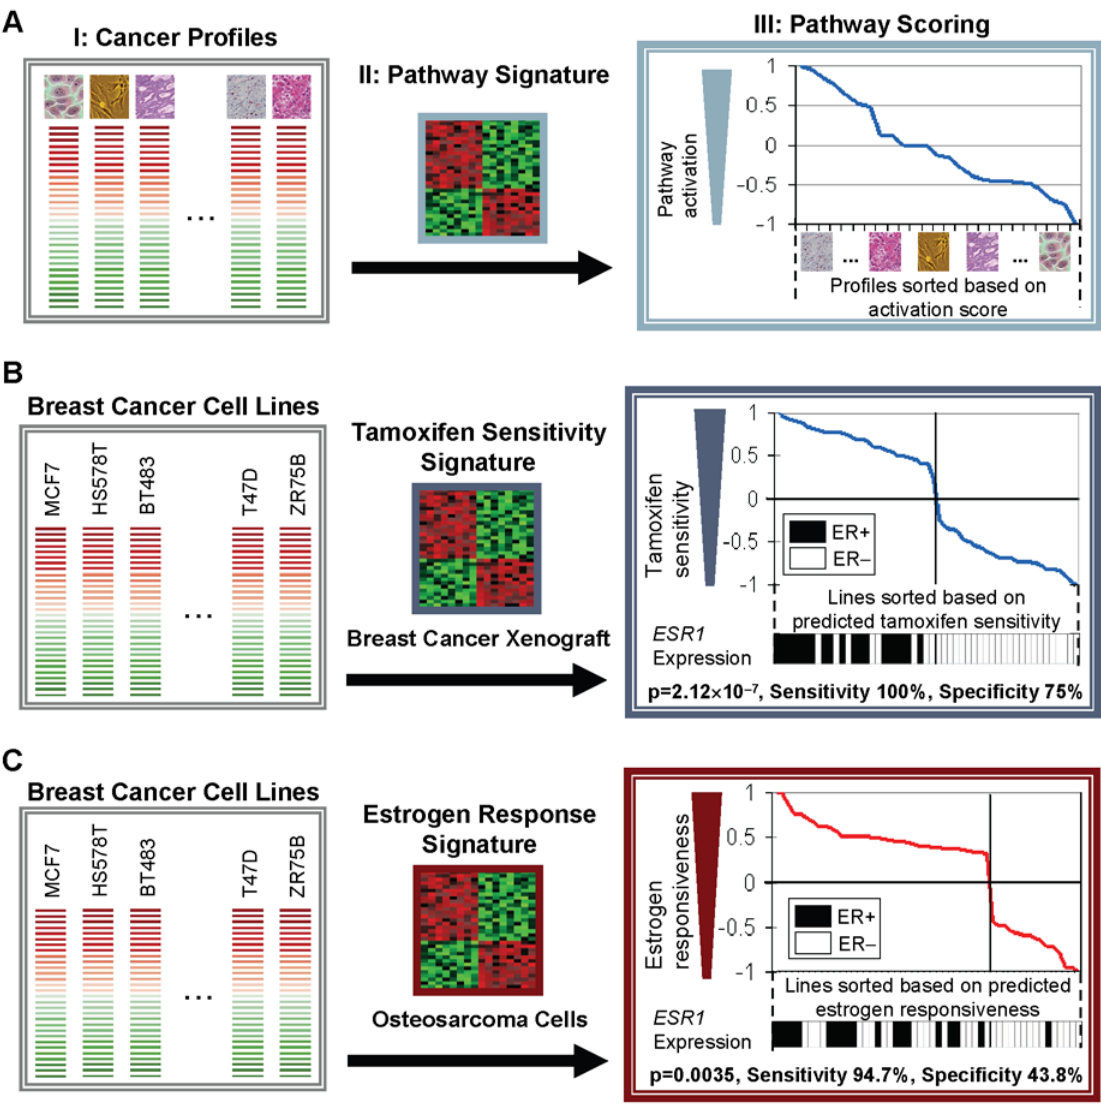
Figure 1. Predicting pathway activation in cancers using gene expression signatures. (A) Schematic of the pathway prediction workflow. I) Expression profiles of a set of cancer samples are pre-processed to identify differentially expressed genes (red and green) compared against a common reference. II) A pathway signature is derived from an independent study concerning the cellular pathway of interest. III) The cancer profiles are compared to the pathway signature using connectivity metrics [37], and subsequently sorted against one another according to the strength of pathway association (pathway scoring). (B) Pathway predictions in breast cancers using a breast-derived tamoxifen sensitivity signature are corroborated by ESR1 (estrogen receptor) expression, which was used to determine estrogen receptor (ER) status (ER-positive or ER-negative). The cancer profiles are a collection of 51 breast cancer cell lines [18], and the pathway signature generated by comparing a tamoxifen-sensitive mammary xenograft (MaCa 3366) to its tamoxifen-resistant subline (MaCa 3366/TAM) [19]. (C) Pathway predictions in breast cancers using an osteosarcoma- derived estrogen response signature are corroborated by ESR1 (estrogen receptor) expression. The cancer profiles are a collection of 51 breast cancer cell lines [18], and the pathway signature generated by identifying genes upregulated by estradiol in U2OS osteosarcoma cells [20]. P-values were computed using Pearson’s chi-square test, under the null hypothesis that the pathway predictor delivers comparable performance to a random predictor. The ESR1 gene is absent from both the 11-gene tamoxifen sensitivity signature and the 41-gene estrogen response signature. Only a two- gene overlap exists between both signatures.